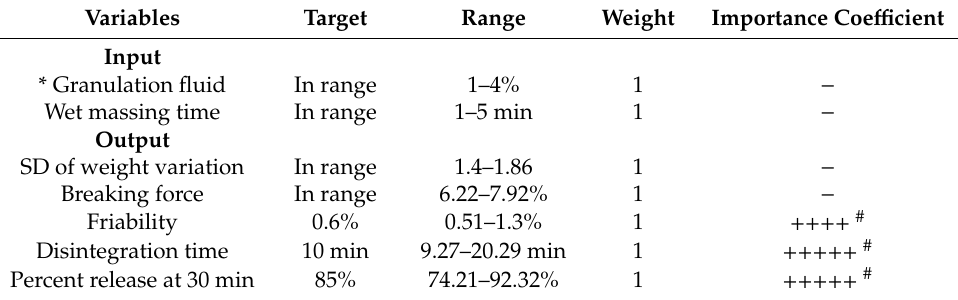
Table 6. The constraints adopted for optimization of process variables and determination of overall desirability.